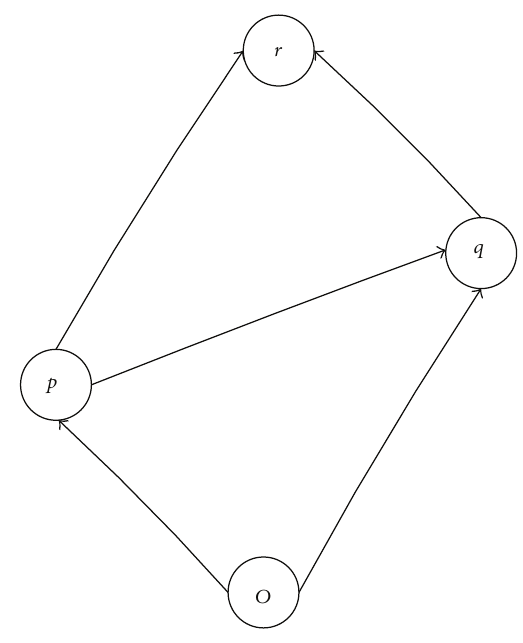
Figure 1: The four-link network. Figure 2: The five-link